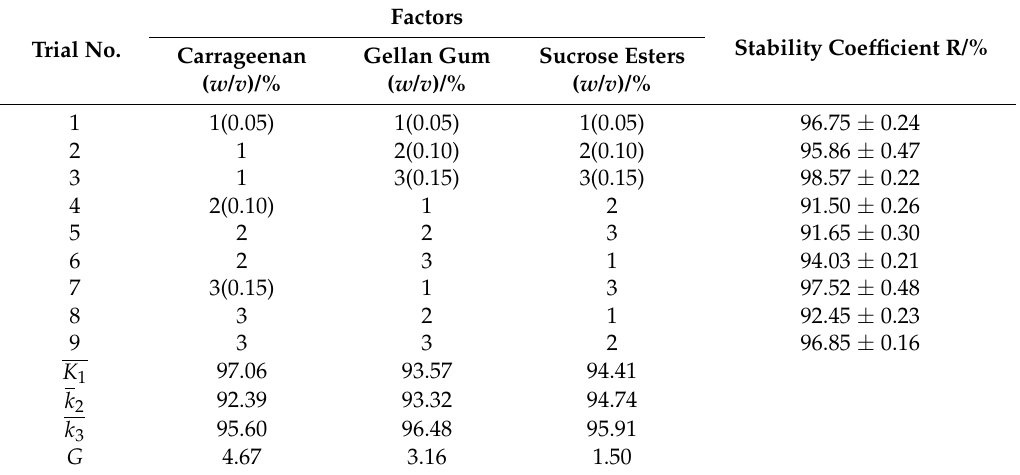
Figure 5. Effect of different stabilizers on stability coefficient R of goat milk catalyzed by CEP of L. plantarum LP69. The error bars represent standard deviation of means ( n = 3). Table 2. The analysis of orthogonal experiments for stabilizers in goat milk catalyzed by CEP of L. plantarum LP69.